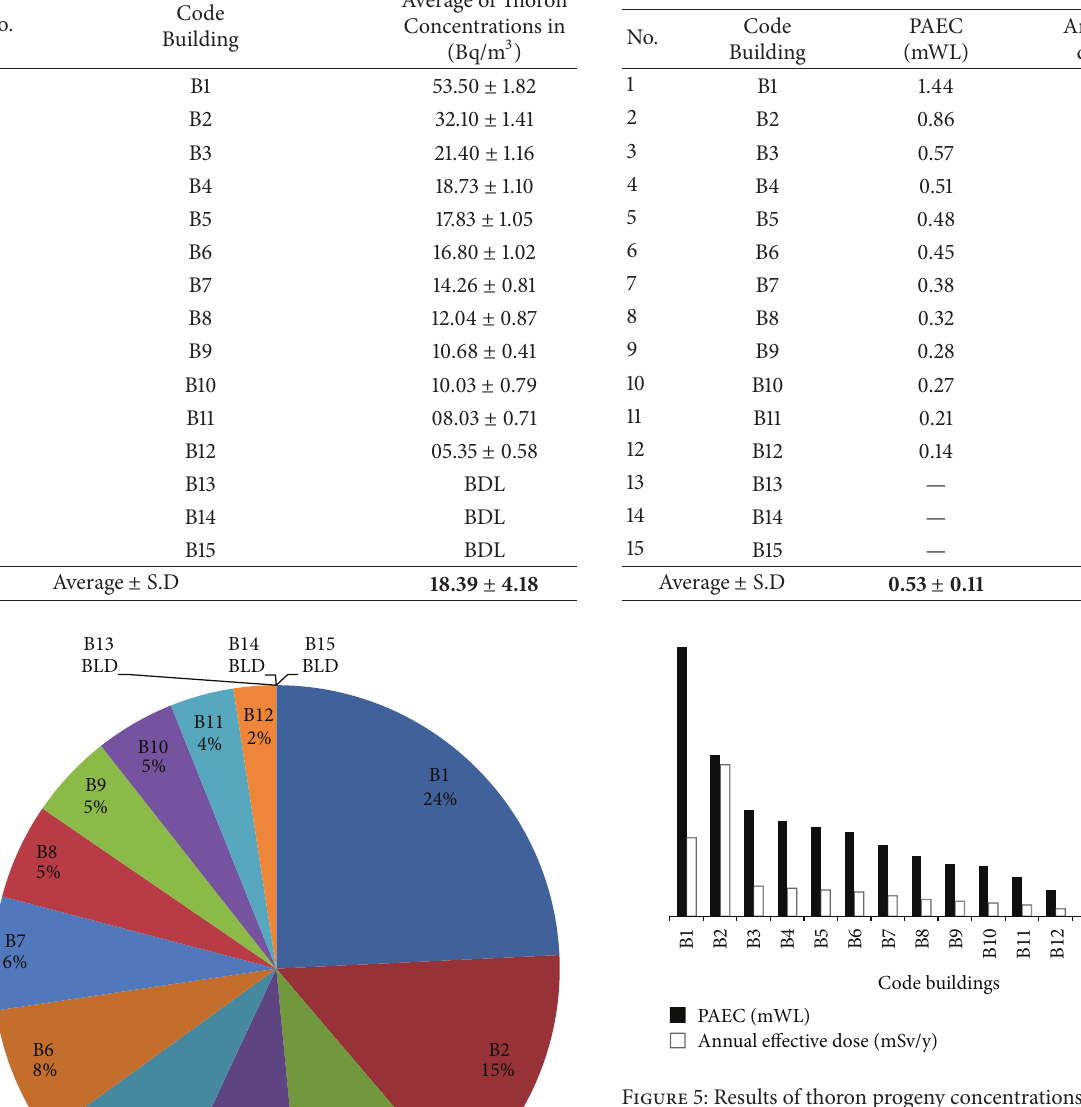
Figure 5: Results of thoron progeny concentrations and the annual effective dose in building under